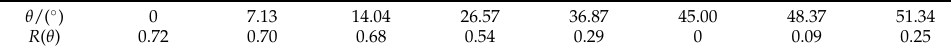
Figure 3. Bragg resonance reflection coefficients of regular waves under different wavenumber ratios f : ( a ) Forward incident condition ( θ =0°); ( b ) Oblique incident condition ( θ =19.5°). Table 2. Reflection coefficients R ( θ ) of Class I Bragg resonance at different incident angles θ .